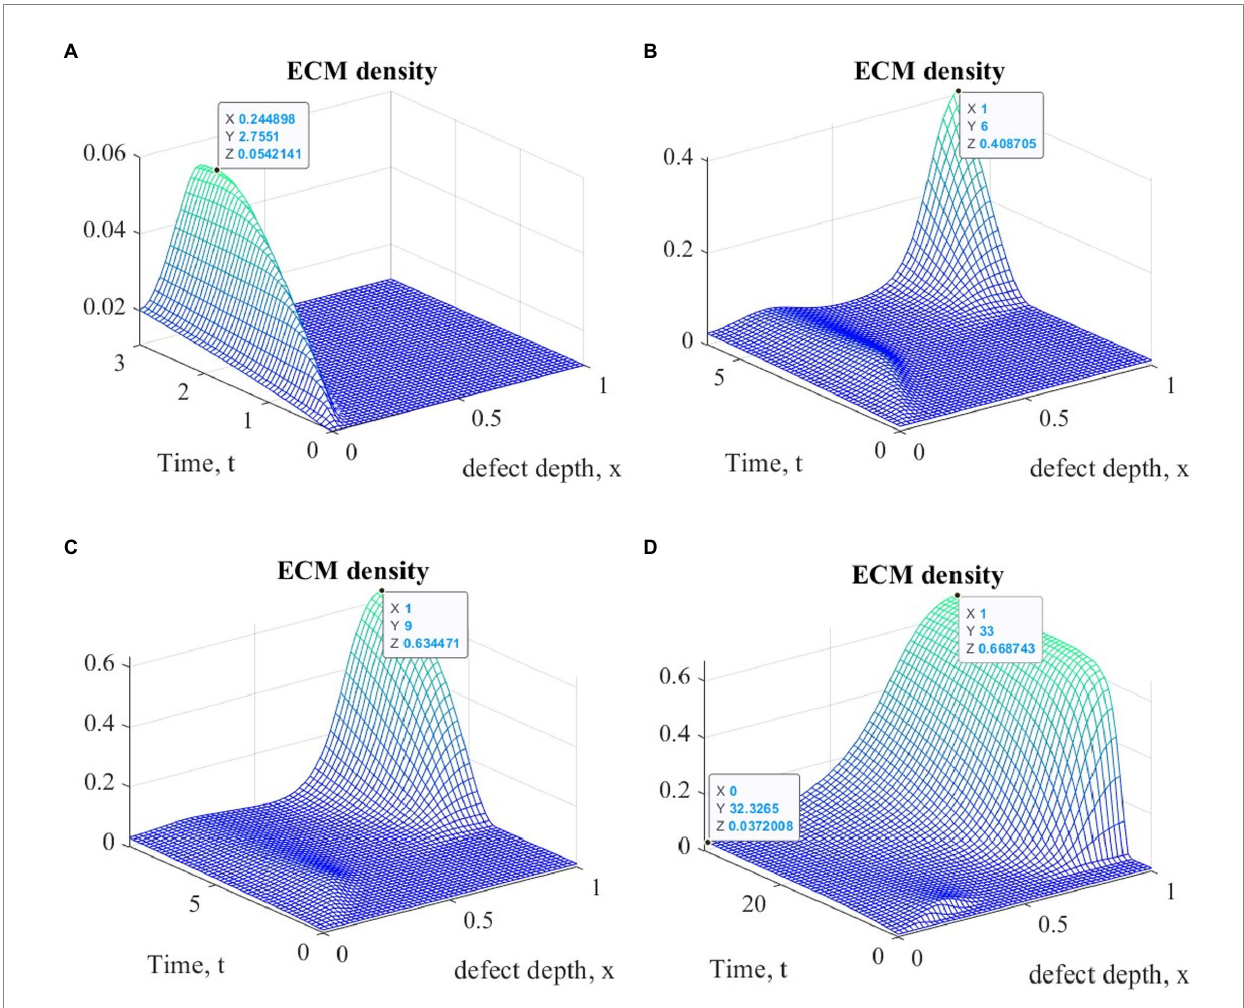
FIGURE 4 Graphs of changes in ECM density at different time points in the implementation of ASIT with mechanical stimulation with a time delay t